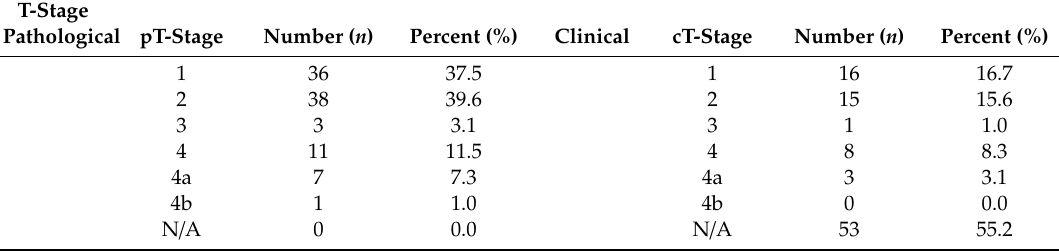
Table 2. Clinical and pathological classification of tumor size.